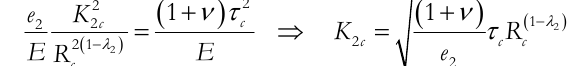
F AILURE CRITERIA FOR SHARP V- NOTCHES UNDER PURE M ODE II LOADING Averaged strain energy density (SED)